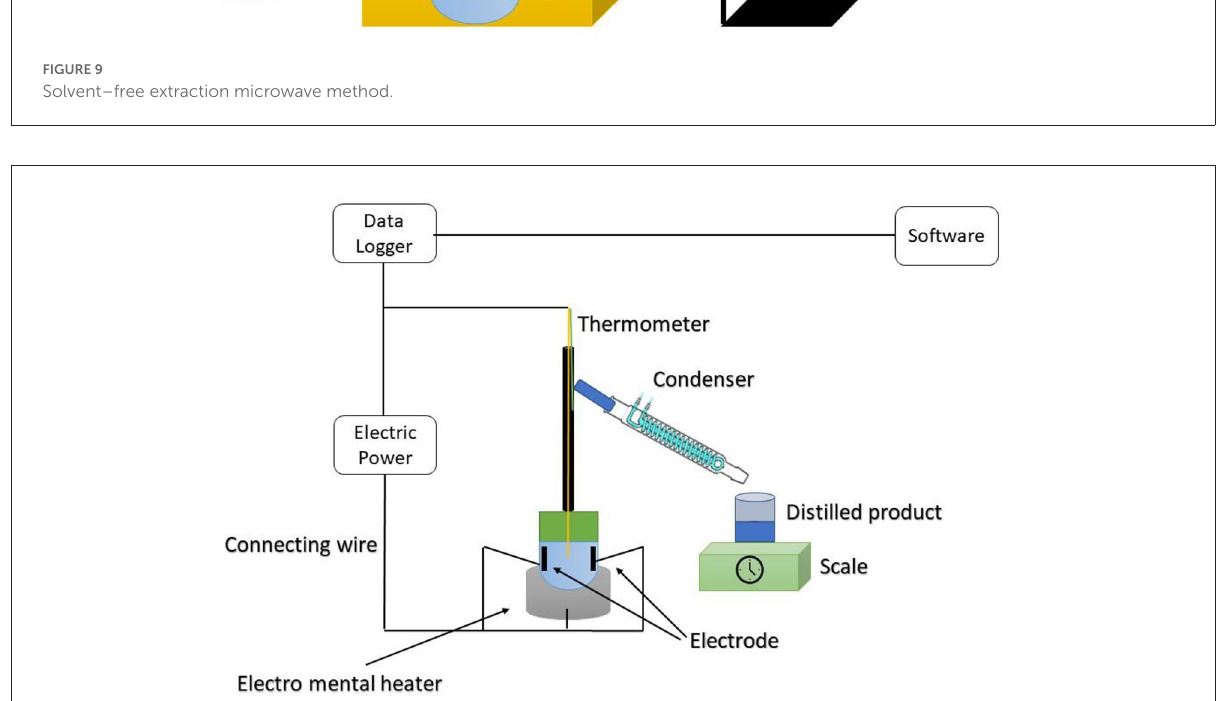
FIGURE10 Ohmic heating